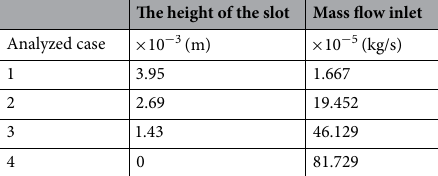
Table 3. Mass flow